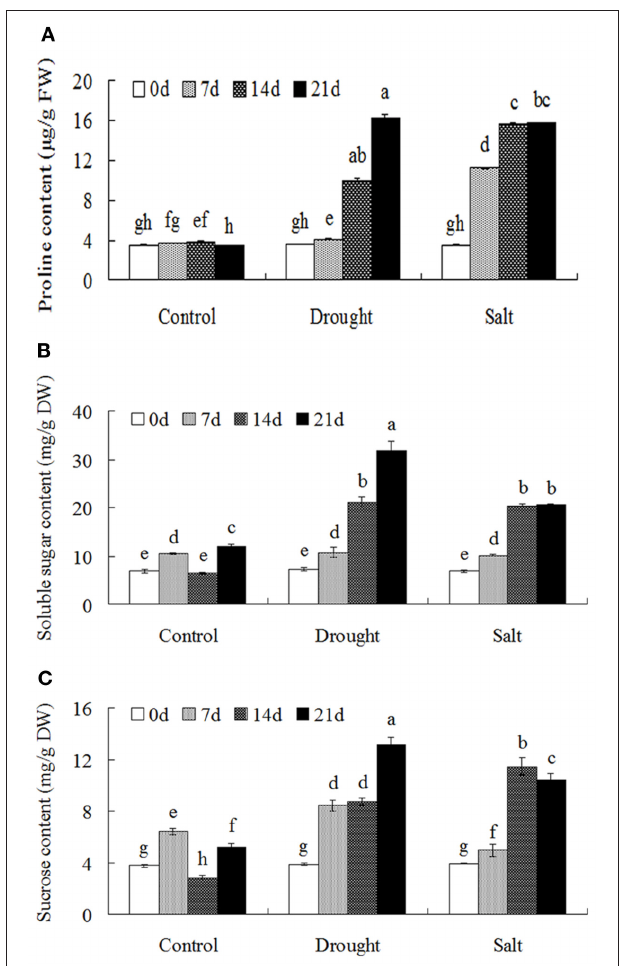
FIGURE 2 | Osmolytes accumulation of bermudagrass that subjected to unstress and stress conditions at designated time intervals. Changes of proline content (A) , soluble sugars (B) and sucrose content (C) of bermudagrass during under control and stress conditions at indicated days. The results shown are means ± SE ( n = 4), and the results followed by different letters are significantly different from each other at P < 0.05 according to Duncan’s